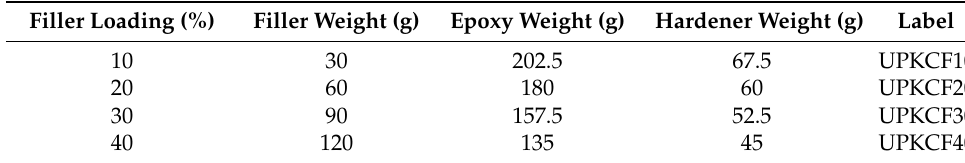
Table 2. Composition of untreated PKCF/ER composites.